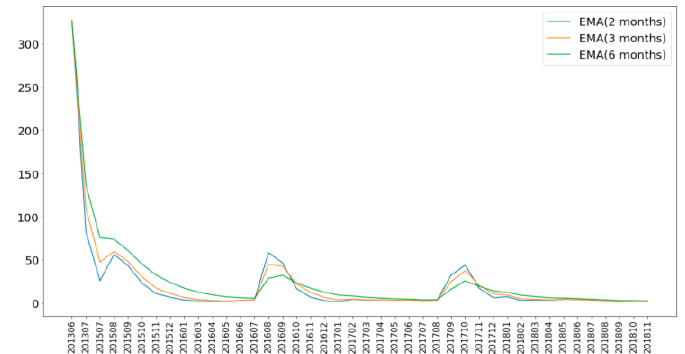
Figure 5. EMA of each month. Table 4. Data source and detailed contents.